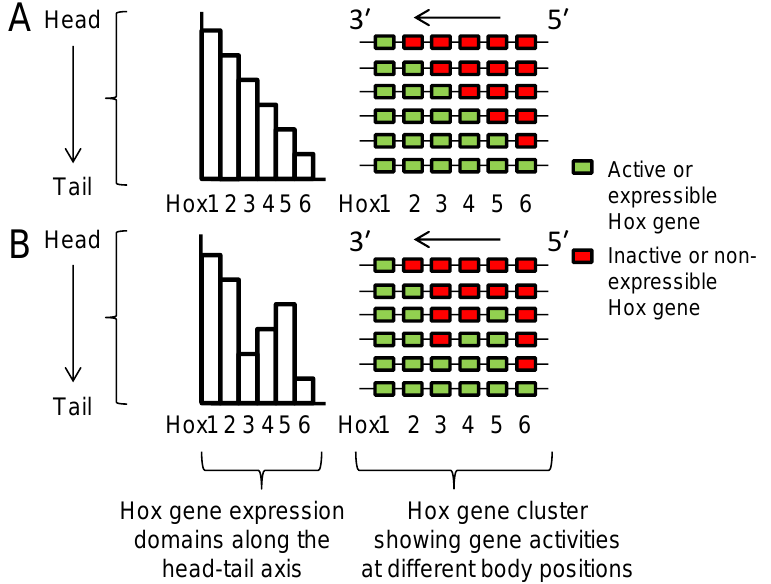
Figure 2. Hox expression patterns which do, or do not, conform to Lewis’s collinearity model. ( A ) Conforming to Lewis’s model for Drosophila [7], and as now known to apply in many different animals [5,6], Hox genes are expressed in a series of partially overlapping domains along the body with the order of genes along the cluster being collinear with the order of their expression domains along the head – tail axis. This is shown in Figure 2A-left, and the genes active at different positions along the body are shown in Figure 2A-right. ( B ) Scenario where Hox3 and Hox5 gene expressions do not conform to collinearity. Arrows show directions of transcription. Figure from Gaunt 2015 [8].